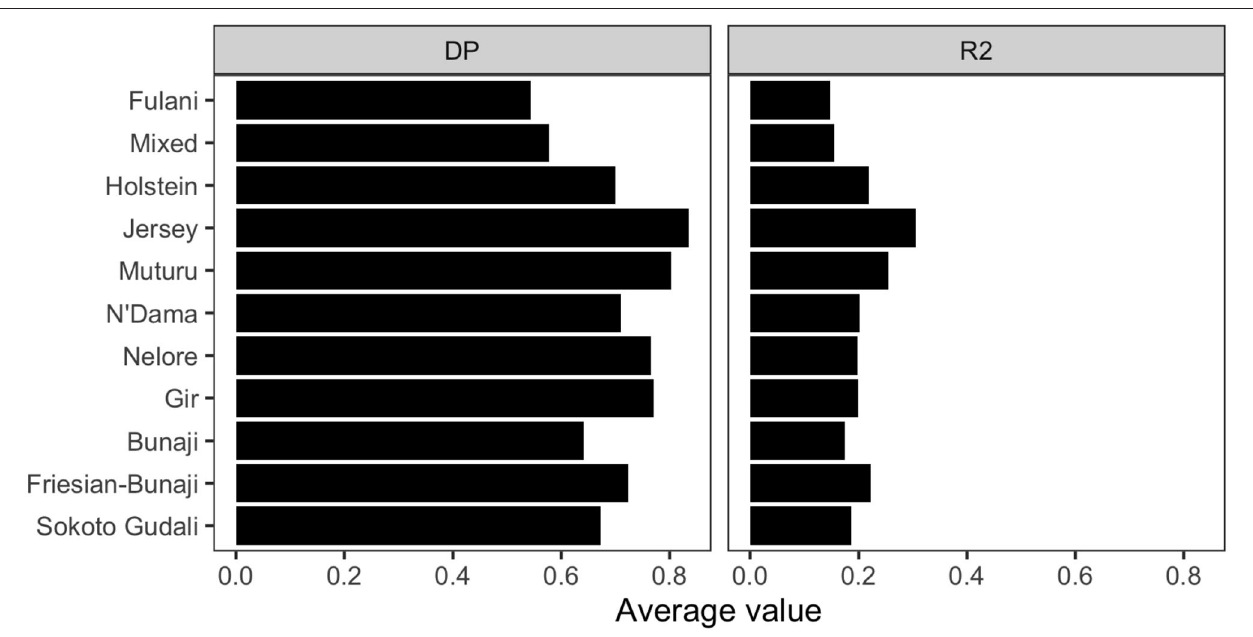
FIGURE 7 | The average linkage disequilibrium as given by D ′ and r 2 for each breed.